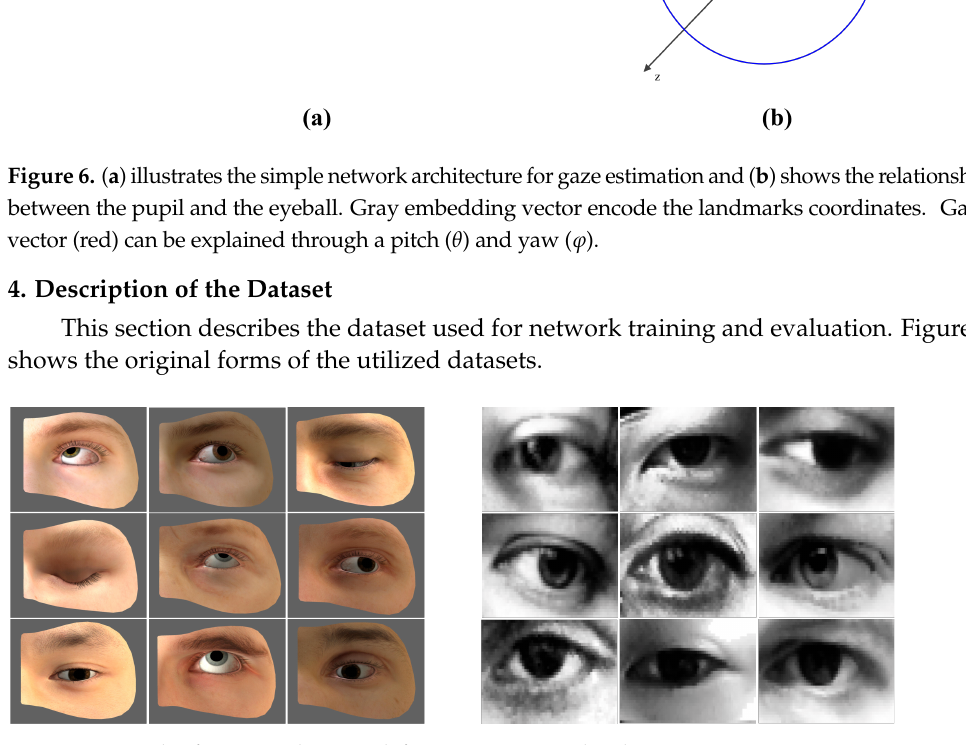
Figure 7. Samples from two datasets: left is UnityEyes and right is